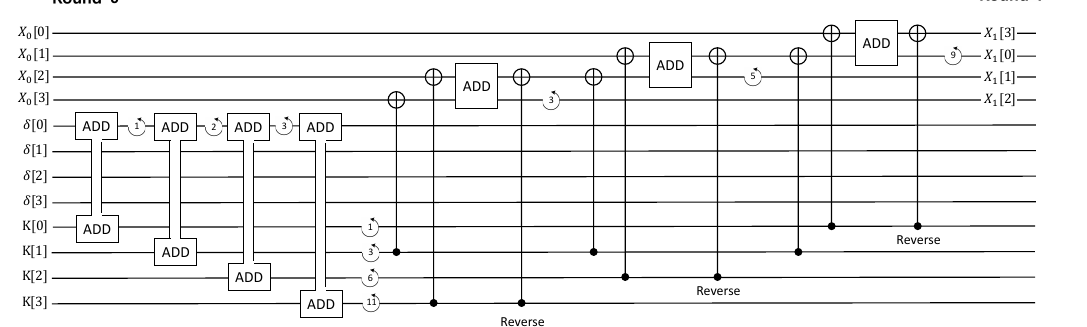
Figure 13. Quantum circuit for LEA-128.